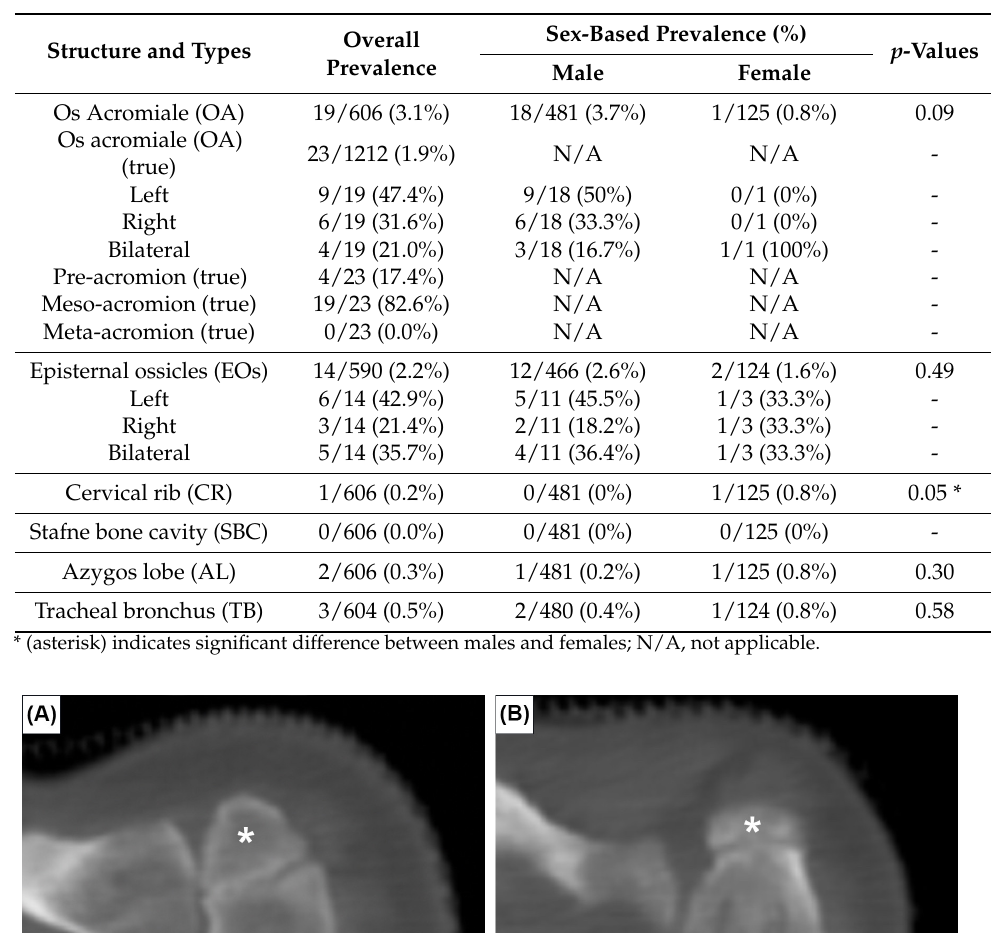
Table 1. Overall prevalence of anatomical variations observed in OPC-Radiomics computed-tomography dataset. p -values indicate sex differences. All prevalences are crude unless stated otherwise.